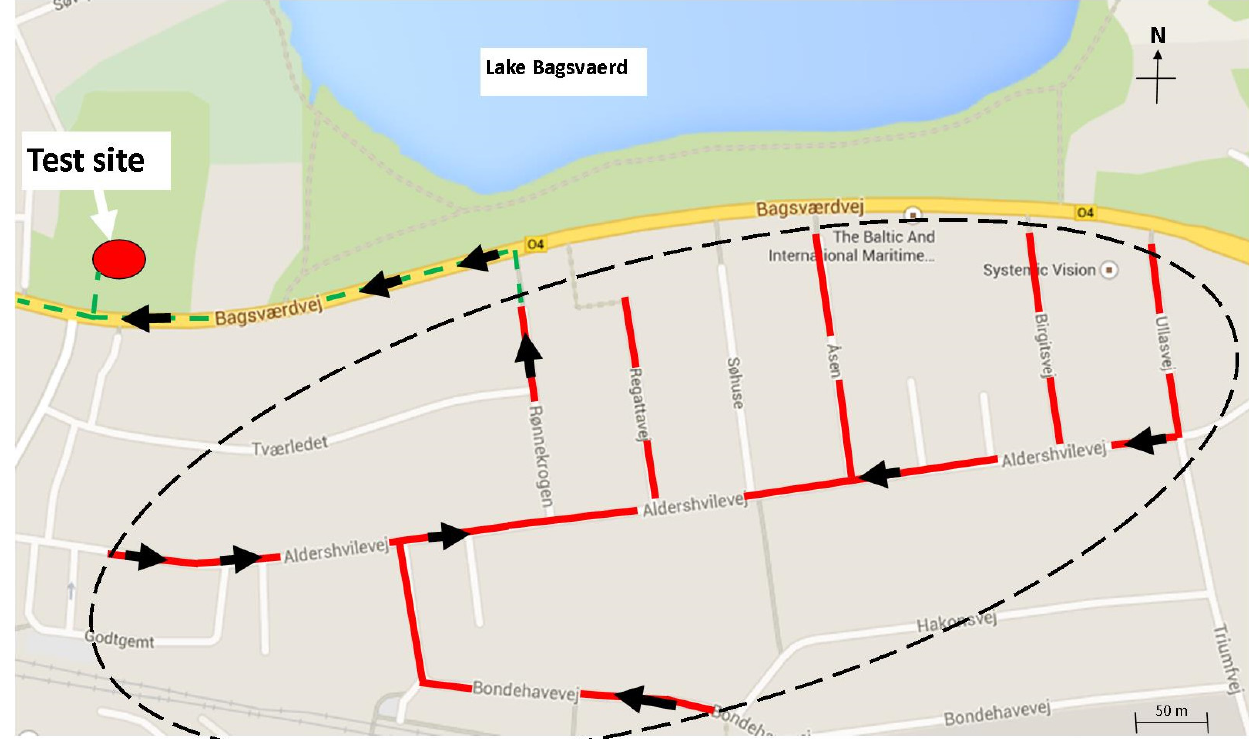
Figure 1. Catchment area circled with the dash (black) line, from where the stormwater runoff is collected. The bold line (red) indicates the separate sewer system. The dash (green) line indicates the stormwater-pipe system removing the stormwater from the area. The arrows indicate the flow direction.